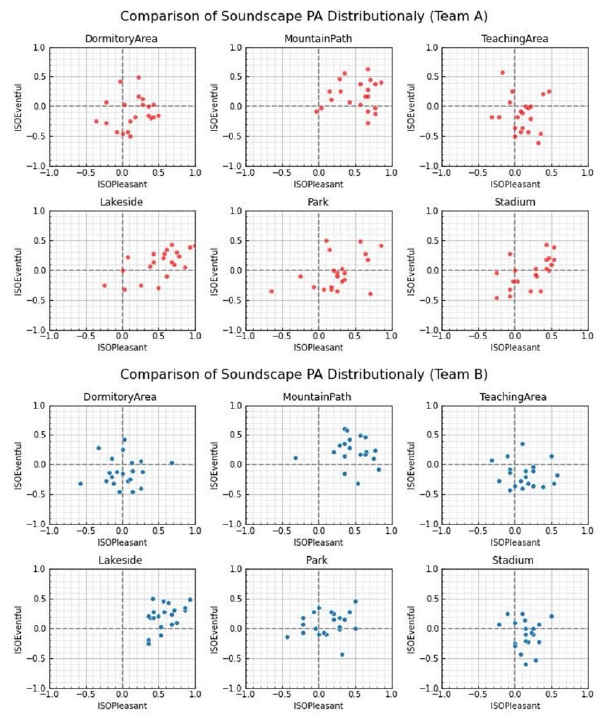
Figure 4. Soundscapy scatterplots.